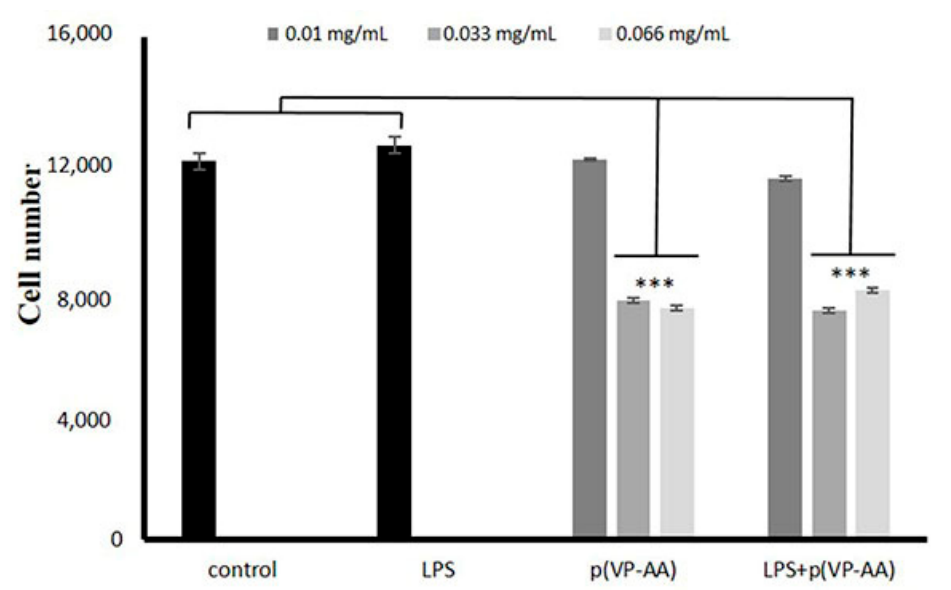
Figure 5. Effect of p(PV-AA) NPs of HMEC-1 cells’ growth. Basal state and activated with LPS HMEC-1 cells were cultured in 96-well plates and treated with p(PV-AA) NPs for 48 h. Cell number was determined utilizing the CyQuant Proliferation assay. The results represent the average of three separate experiments. Statistical significance: *** p ≤ 0.001 compared to controls.